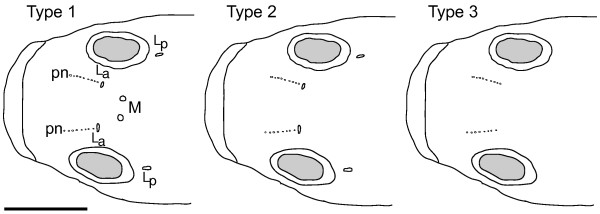
Schematic dorsal view of the oculoscapular canal section of the defined canal morphotypes. The canal structures are evident by presence of pores at their extremities. Median pores (M), lateral pores (La = anterior, Lp = posterior lateral pore) and primary neuromasts (pn). Scale bar = 10 mm.